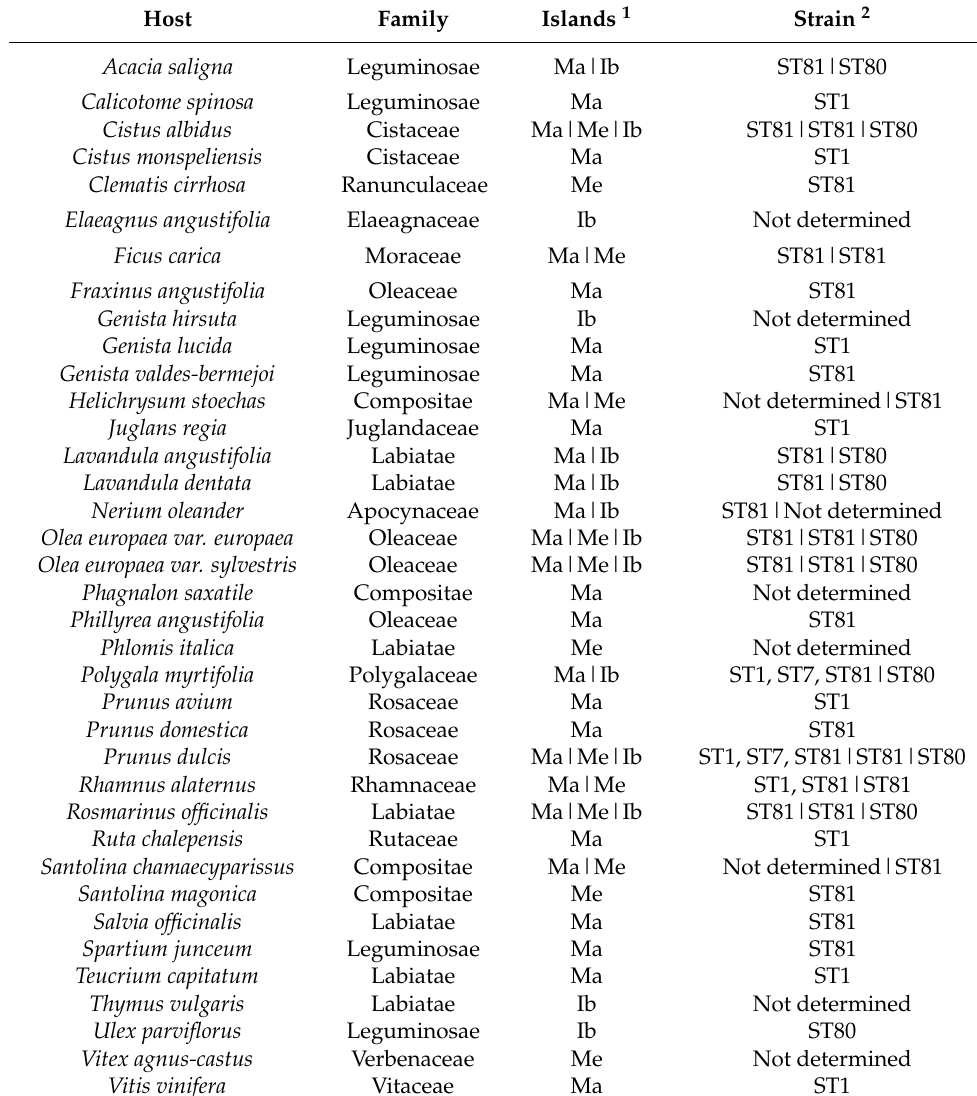
Table 1. Host plants for Xylella fastidiosa recorded in the Balearic Islands in 2022. Host